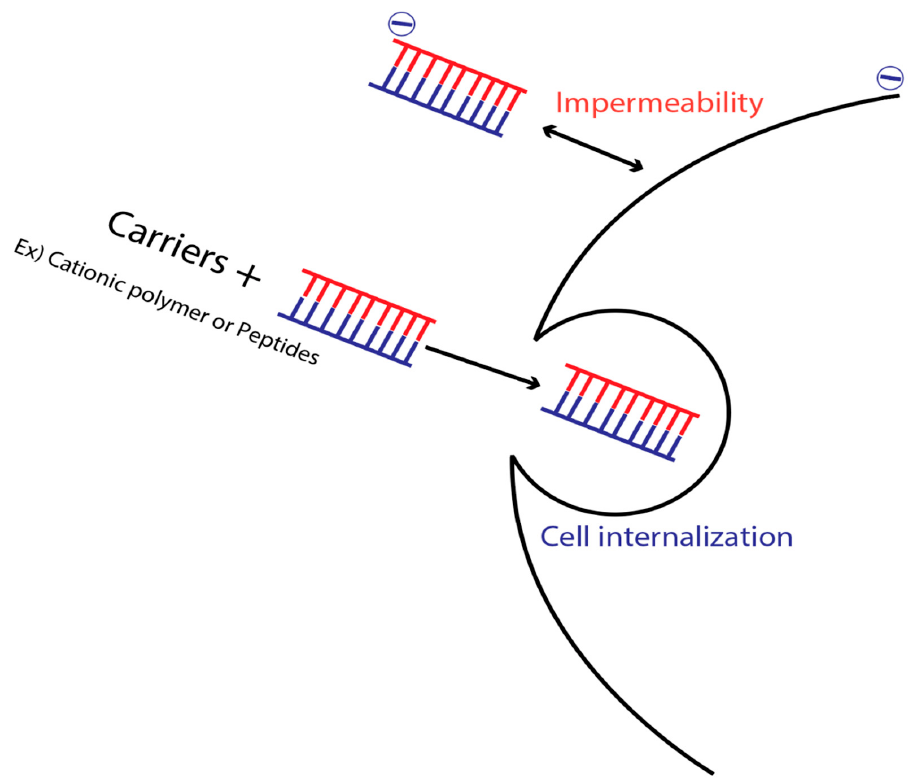
Figure 5. Carriers to overcome the impermeability of the siRNA.